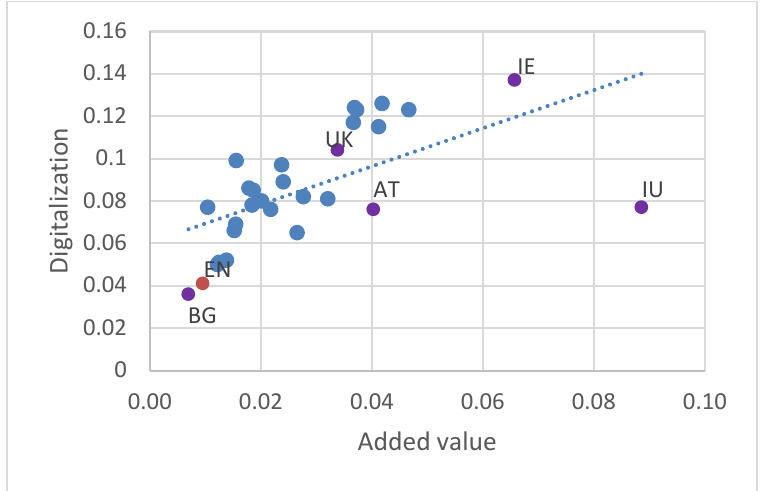
Figure 4. The relationship between digital integration and the EU added value in 2019.